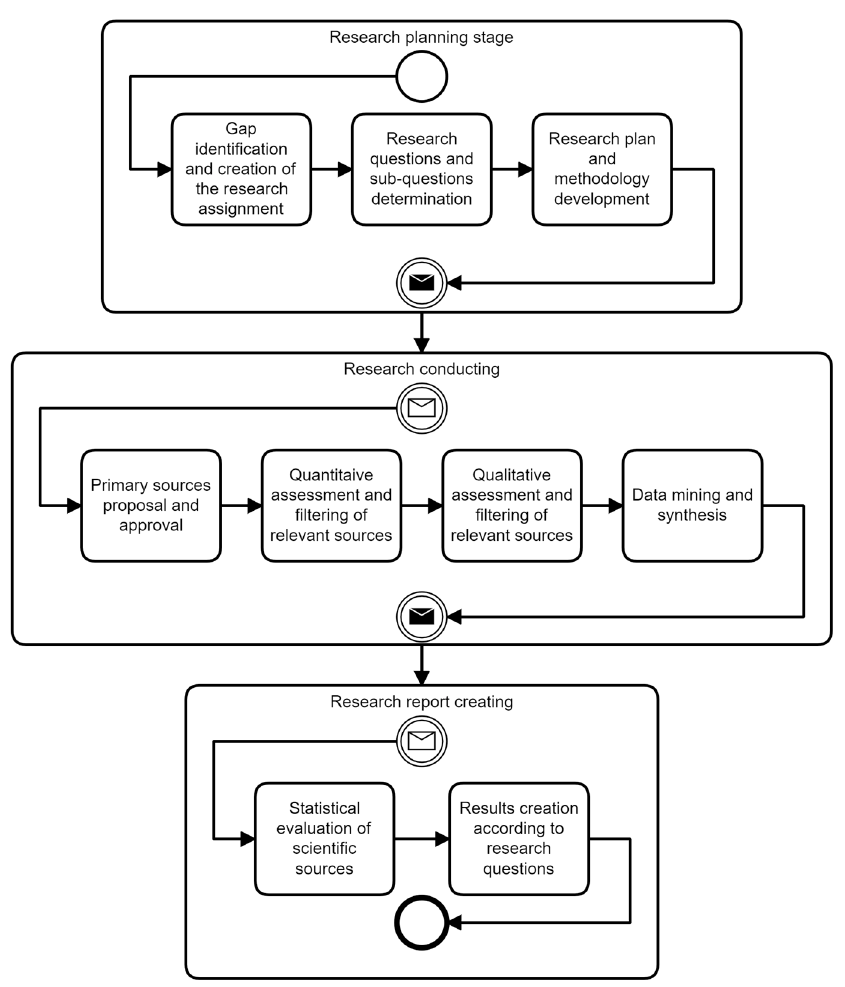
Figure 1. Diagram of the systematic literature search process. Source: own processing.